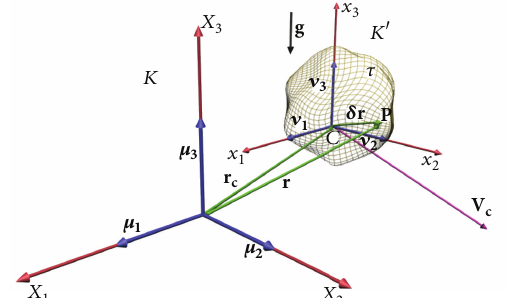
Figure 1: Cartesian coordinate system 𝐾 of a Galilean frame of reference and the continuum region mass center-affixed Lagrangian coordinate system 𝐾 󸀠